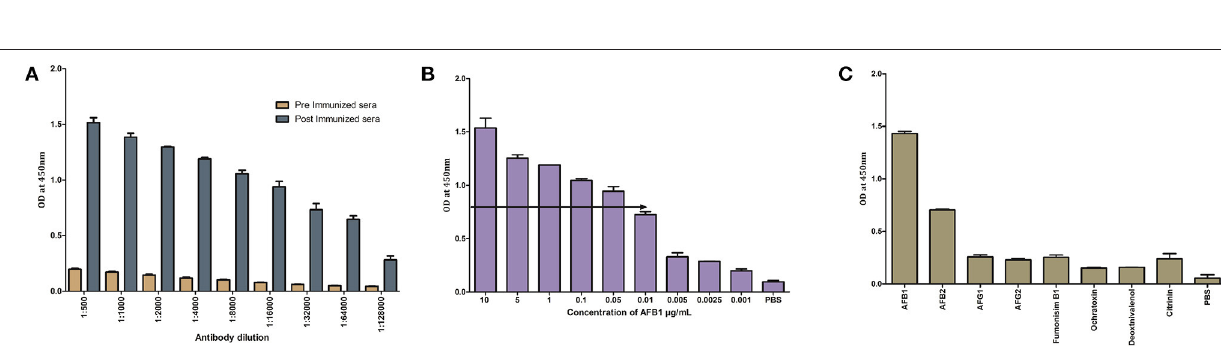
Frontiers in Pharmacology | www.frontiersin.org